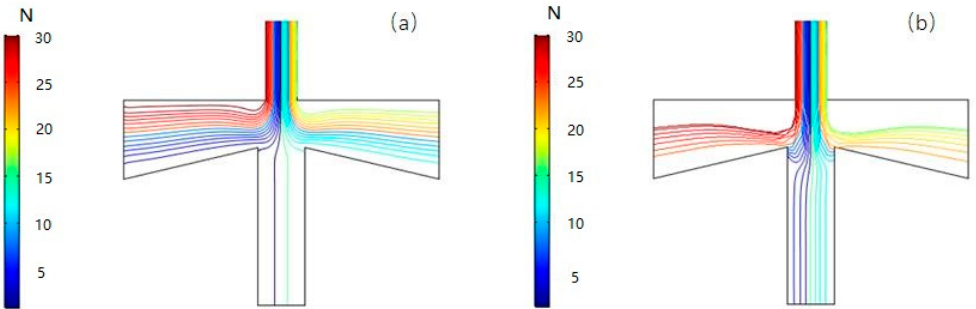
Figure 11. Particle trajectory of VI at 2 mL/min ( a ) and 10 mL/min ( b ).